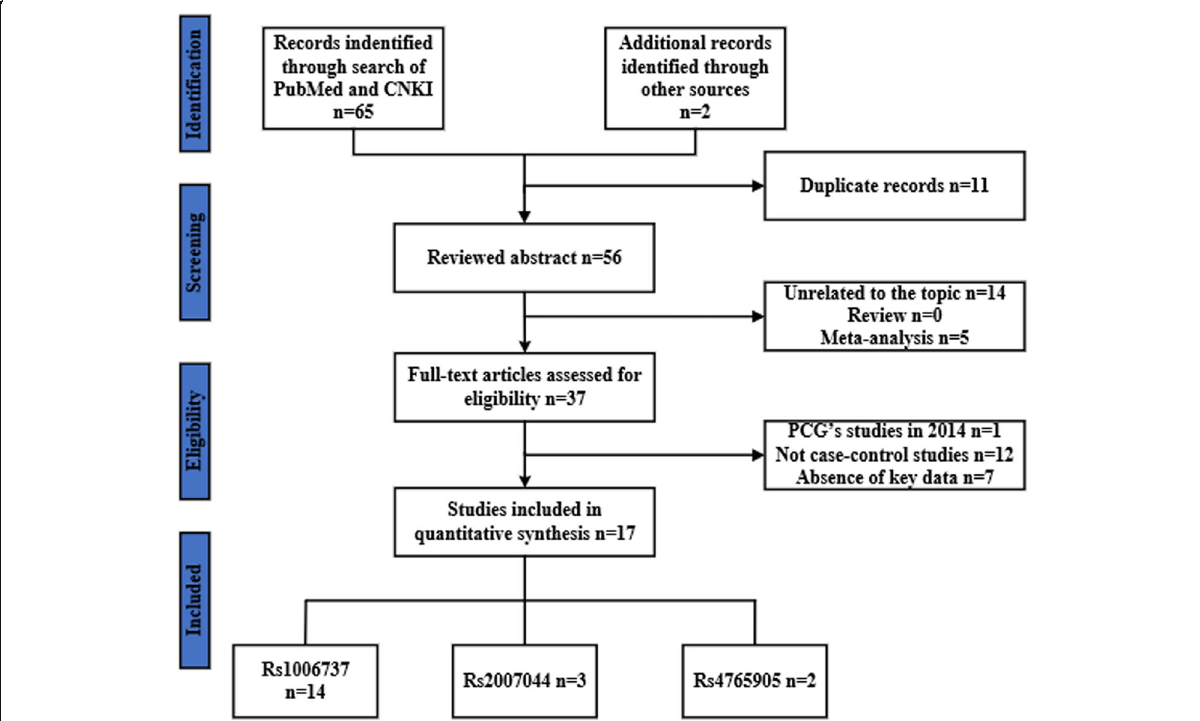
Fig. 1 Flow diagram for the search and selection of the included studies. A total of 67 relevant English and Chinese studies were retrieved from the PubMed and CNKI databases. Following removal of the studies that did not meet our inclusion criteria, a total of 19 studies were included in the meta-analysis, including 14 rs1006737 studies, three rs2007044 studies, and two rs4765905